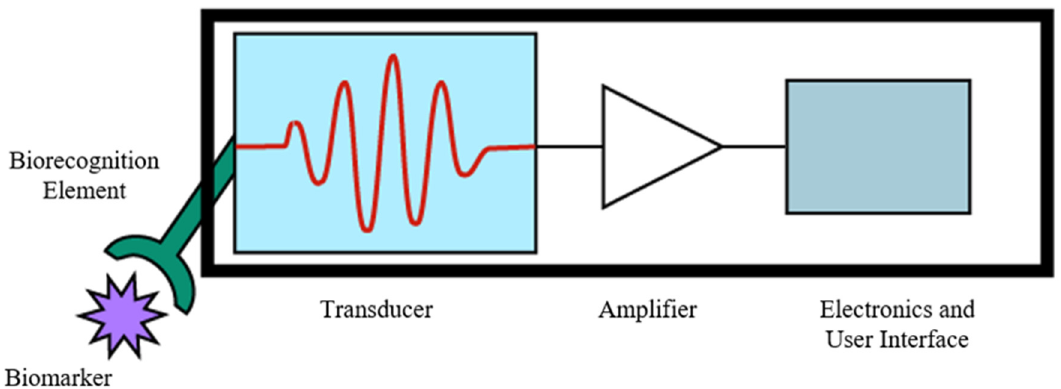
Figure 5. Generalized schematic for the components of a diagnostic biosensor: the target biomarker (protein, nucleic acid sequence, antibody, etc.), the biorecognition element (peptide, antibody, enzyme, etc.), the transducer (optical, electrical, plasmonic, etc.), and the electronic readout and user interface.